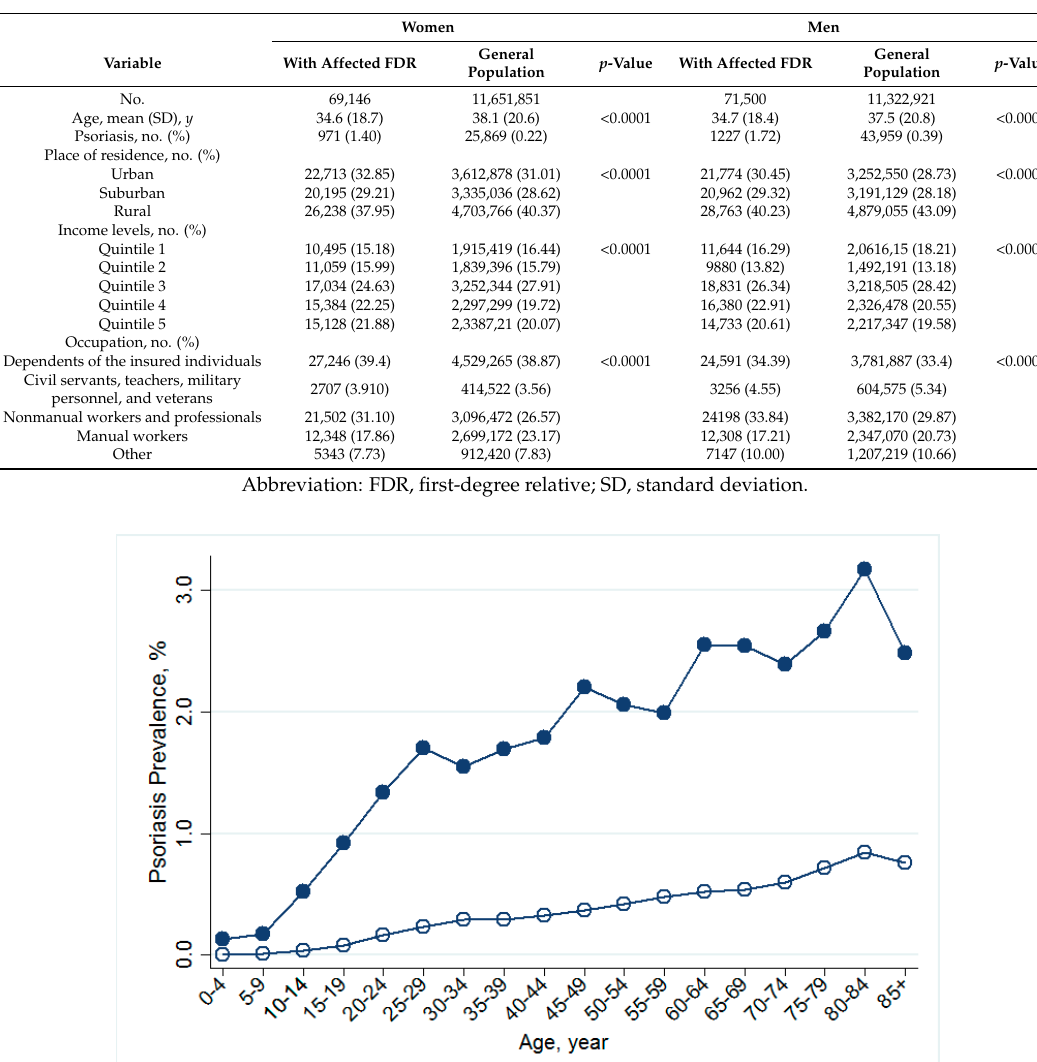
Table 1. Baseline characteristics of individuals with affected first-degree relatives with psoriasis and the general population.